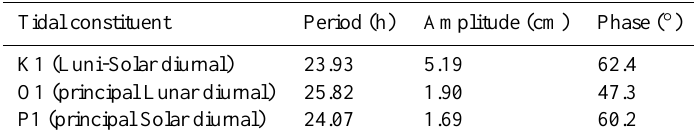
Table 1. Amplitudes and phases of the most significant diurnal tidal constituents at Dubrovnik tide gauge (Hydrographic Institute of the Republic of Croatia, 1973).